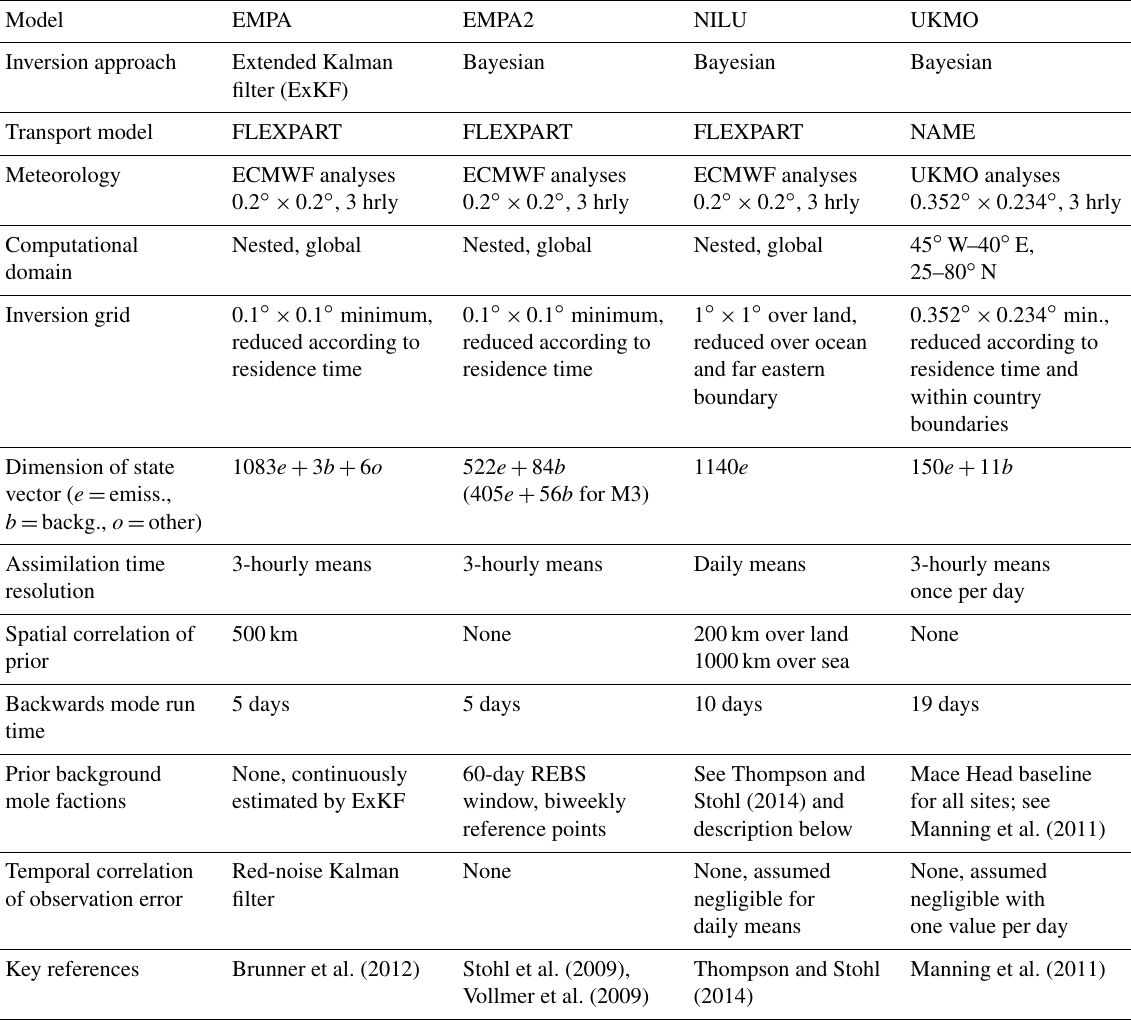
Table 1. Overview of inversion